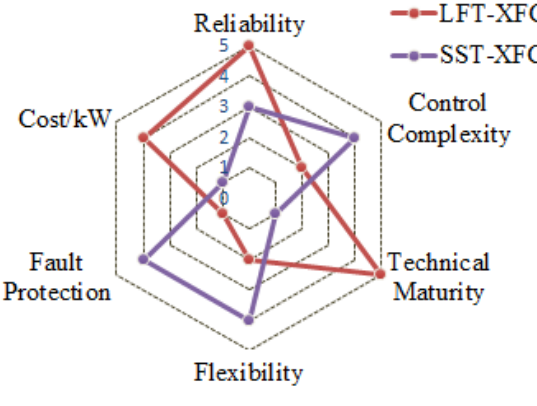
Figure 9. Comparison between LFT and SST based EV charging